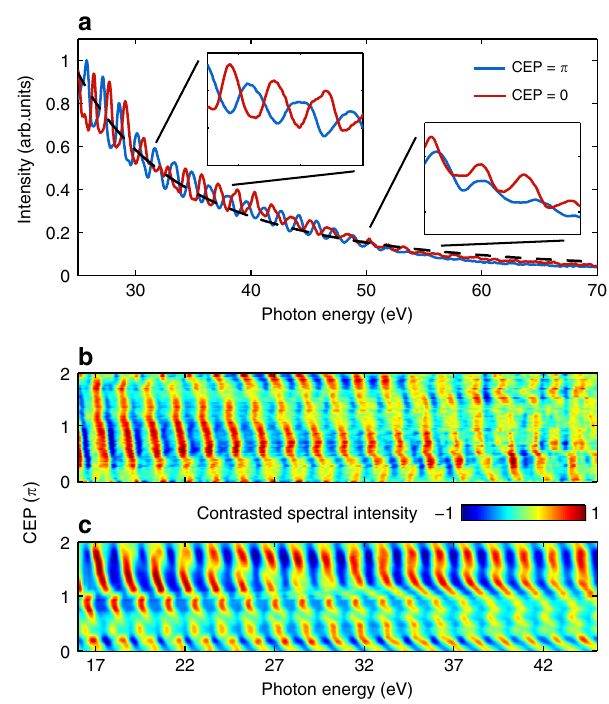
Fig. 2 CEP-dependent XUV emission. a Example of measured XUV spectra generated by the laser pulses with π -shifted ϕ CEP . Two insets demonstrate harmonics photon energy and shape difference in spectral regions 30 – 35 and 50 – 55 eV, respectively. The dashed line is a power law fi t with an exponent of − 2.62. b CEP-sorted experimental XUV spectra for 71 shots for a prepulse delay τ pp = 1.67 ps ( L / λ L ≈ 0.13). c Corresponding CEP dependence obtained from PIC simulations with a scale length of L / λ L = 0.13. Additional contrast enhancement procedure (see Methods) was applied to measured and simulated spectra for better visualization of harmonics photon energy. A vertical running average smoothing of the data in b , c was applied within the CEP measurement error range of ±210